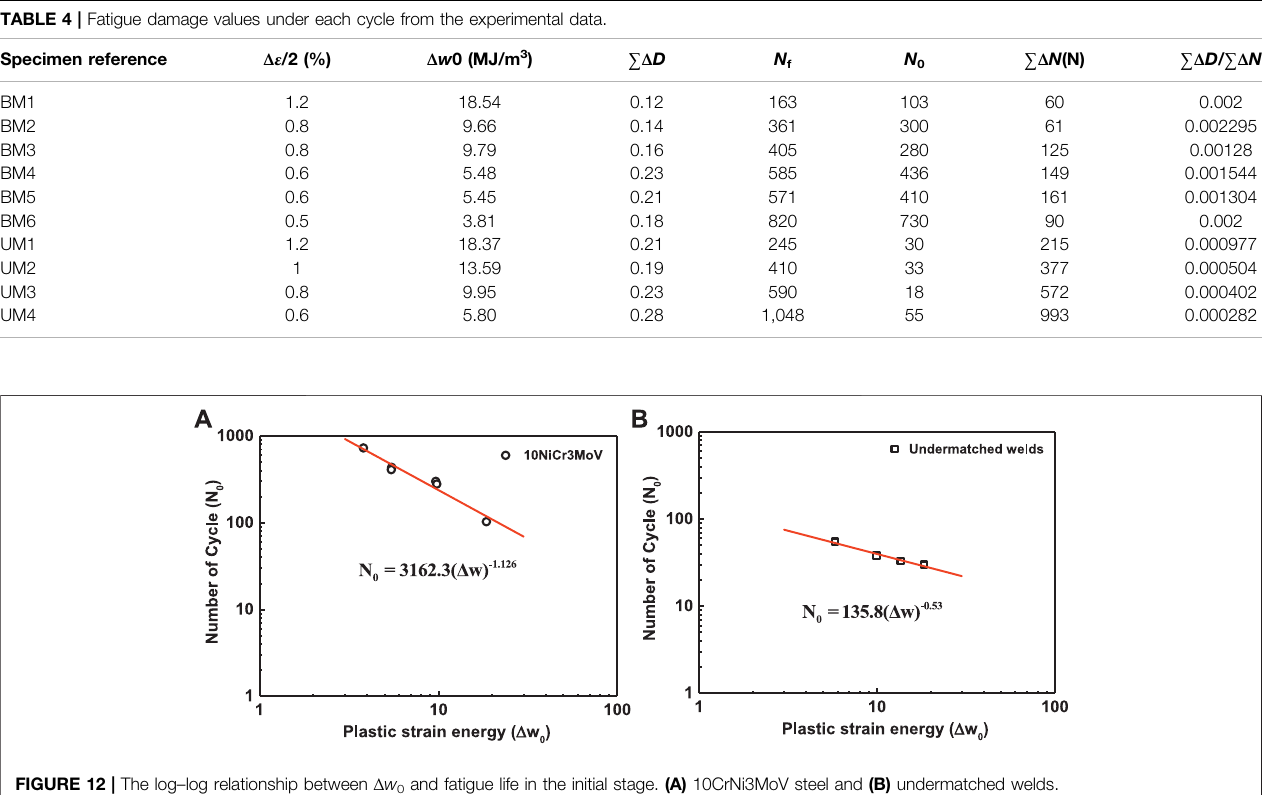
Frontiers in Materials |